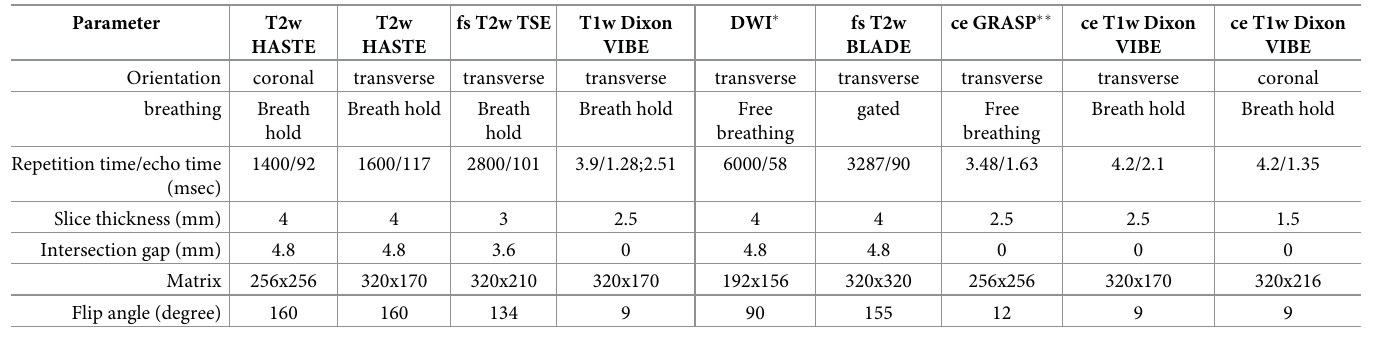
Table 2. Multiparametric pancreatic 3-T MRI sequence